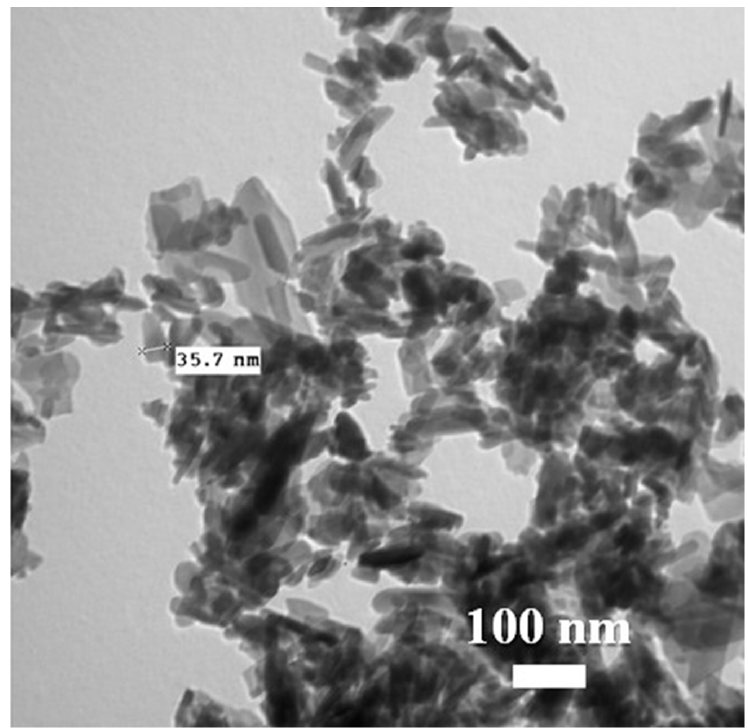
Figure 3. Transmission electron microscopy (TEM) image of nano-hydroxyapatite (n-HAP). 3.2. Effect of n-HAP on Egg Hatching and Juvenile Mortality of Meloidogyne incognita In Vitro The effect of n-HAP, at concentrations 50, 150, and 200 ppm, on the egg hatching of M . incognita was evaluated under laboratory conditions (Table 1). The data showed that all tested concentrations significantly reduced ( p < 0.05) the percentage of egg hatching compared to the untreated control. Generally, the effect of n-HAP varied depending on the exposure time and the concentration. The effect on mortality percentage also revealed that all treatments were characterized by a steady relationship between concentration and exposure time. The obtained data exhibited a normal gradient in the difference in the in- hibitory effect of egg hatching between the tested concentrations after 24 h of exposure. The highest concentration involved 80.71% of inhibition, while the lowest concentration caused 59.16% inhibition compared to the untreated control (Table 1). When the exposure time was increased to 72 h, the actual and continuous effect of n-HAP was observed, and the inhibition rate of the three tested concentrations of n-HAP (50, 150, and 200 ppm) reached 62.20%, 72.82%, and 83.80%, respectively. On the other hand, direct exposure to n-HAP seemed to have a faster effect on the percentage of mortality of second-stage juve- niles than the effect on egg hatching (Table 2). Among them, after 24 h of exposure, the highest concentration of n-HAP (200 ppm) caused 195.67% mortality of J2s, while the low- est concentration (50 ppm) caused 180.16% mortality compared to the untreated control. Mortality was increased with increasing exposure time to 72 h, resulting in the death of all tested individuals. Table 1. Effect of n-HAP on egg hatching of Meloidogyne incognita in vitro. Treatments